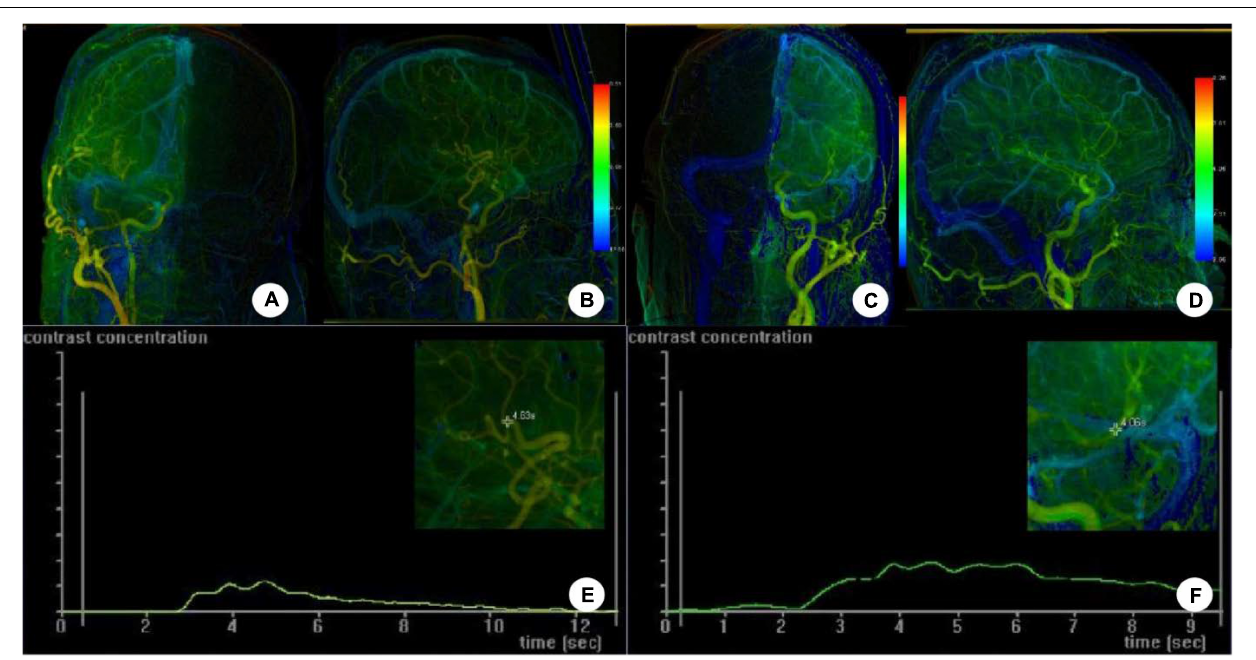
FIGURE 3 | The iFlow color-coded blood flow map was constructed on DSA postoperative cerebral angiographic images. (A–D) Angiography through the external carotid artery showed warm color changes on the diseased side (A,B) , similar to those on the contralateral side (C,D) . (E,F) The time–density curve at the anastomosis and region of interest around the upper and lower trunk of the MCA showed that the contrast agent apparently disappeared at the anastomosis while the contrast agent peak value was significantly increased at the upper and lower trunk of the MCA. The interval from the upper or lower MCA trunk to the upper middle sagittal sinus was roughly the